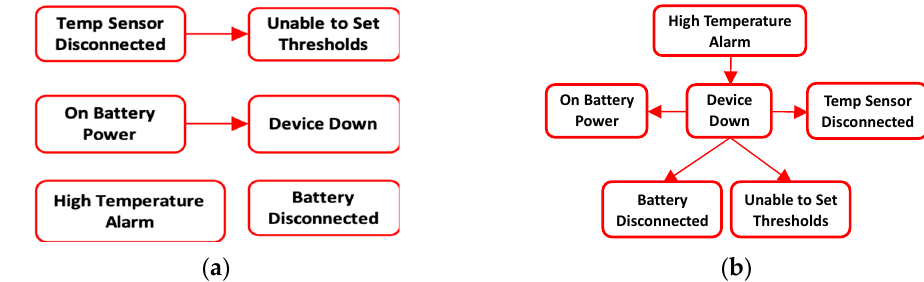
Figure 7. BN DAG structure for the top six occurring UPS messages. ( a ) Correct quantitative BN model DAG obtained from Expert opinion and qualitative data; ( b ) Incorrect quantitative BN model DAG obtained from Hill Climbing score-based BN algorithm.